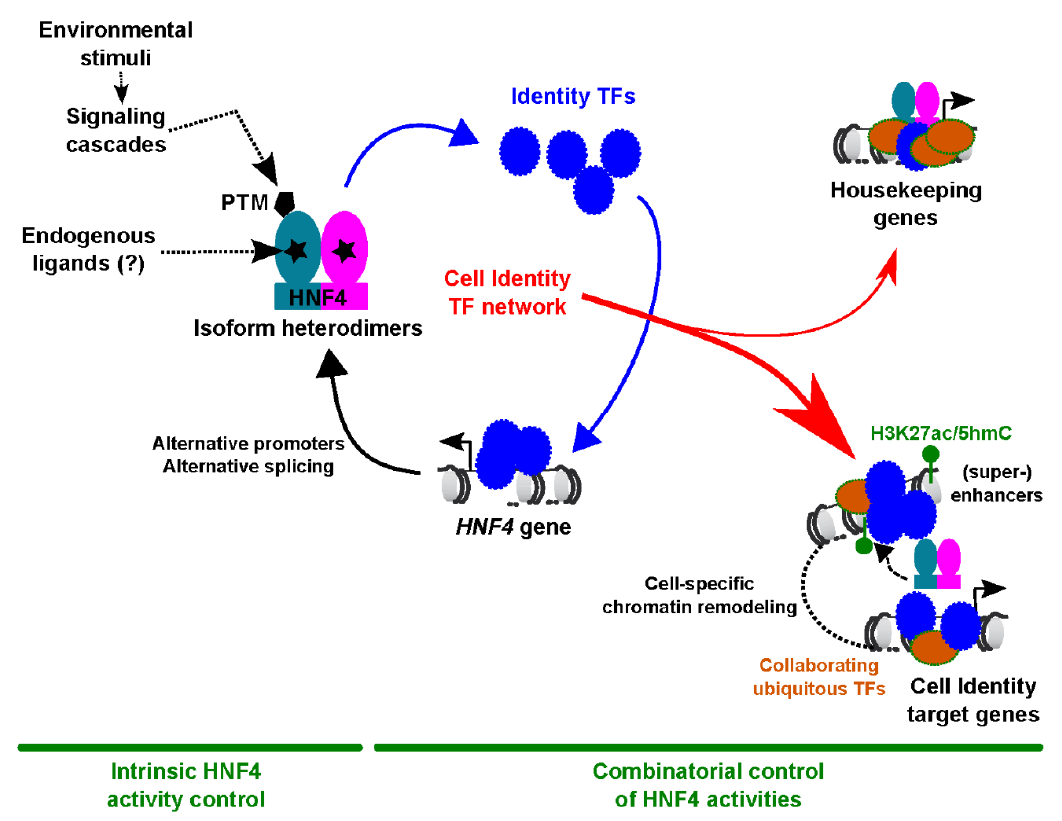
Figure 1. Mechanisms involved in the control of cell identity by HNF4. Intrinsic control of HNF4 activities through isoform heterodimers, post-translational modifications (PTMs), and potential ligands add up to the modulation of its functions through involvement in cell-specific transcription factor (TF) networks. Combinatorial control of cell identity by HNF4 and additional cell identity by TFs consist of 2 interdependent layers where these TFs modulate each other’s expression and coordinately regulate common (non-TF) cell identity target genes.